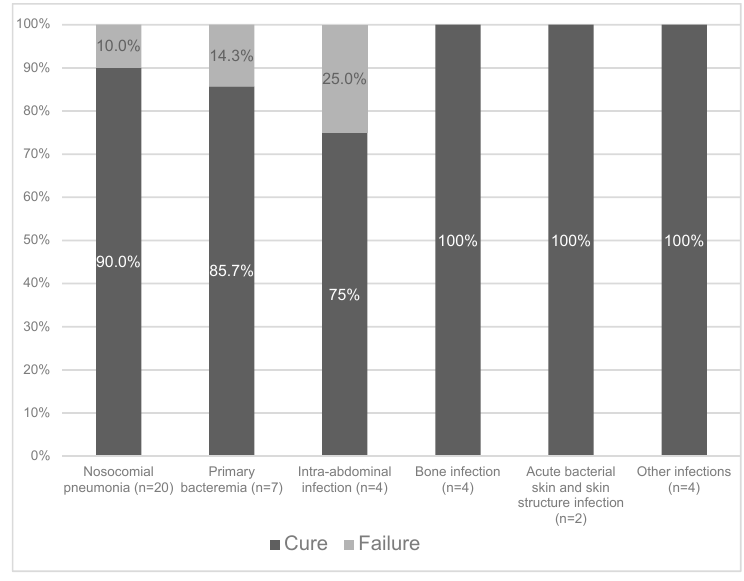
Figure 1. Clinical cure rates according to different types of infection.